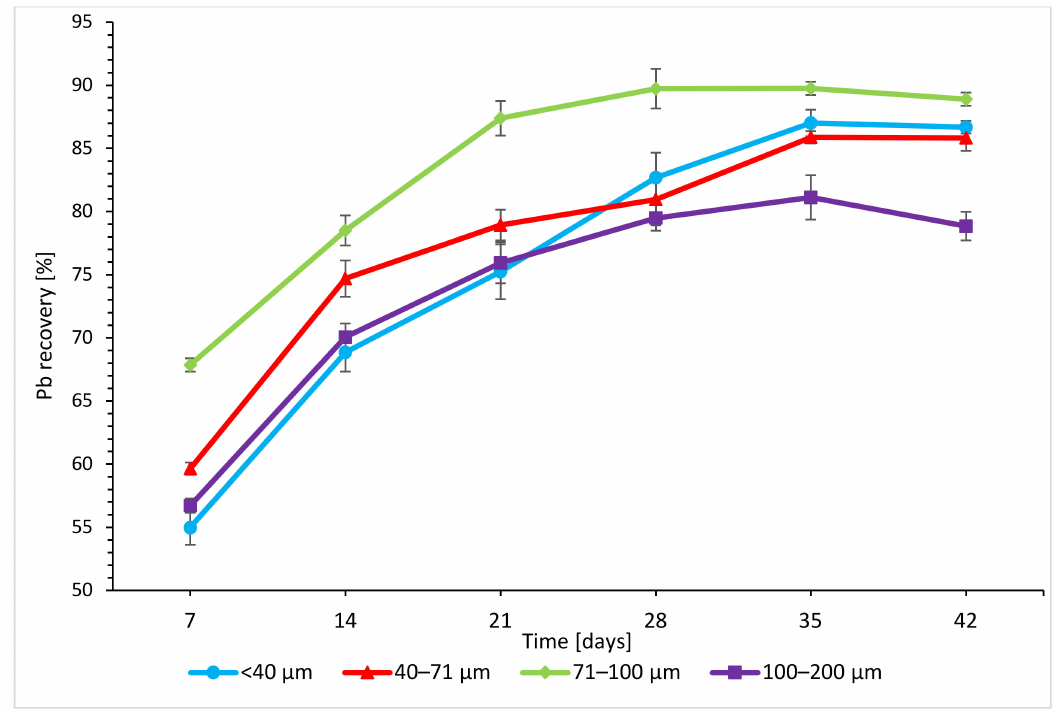
Figure 11. Influence of particle size on Pb recovery (pH 2, stirring speed 100 rpm, and 6.67% ( w / v ) pulp